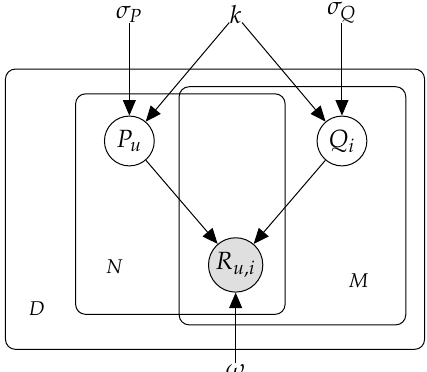
Figure 1. Plate diagram of DirMF